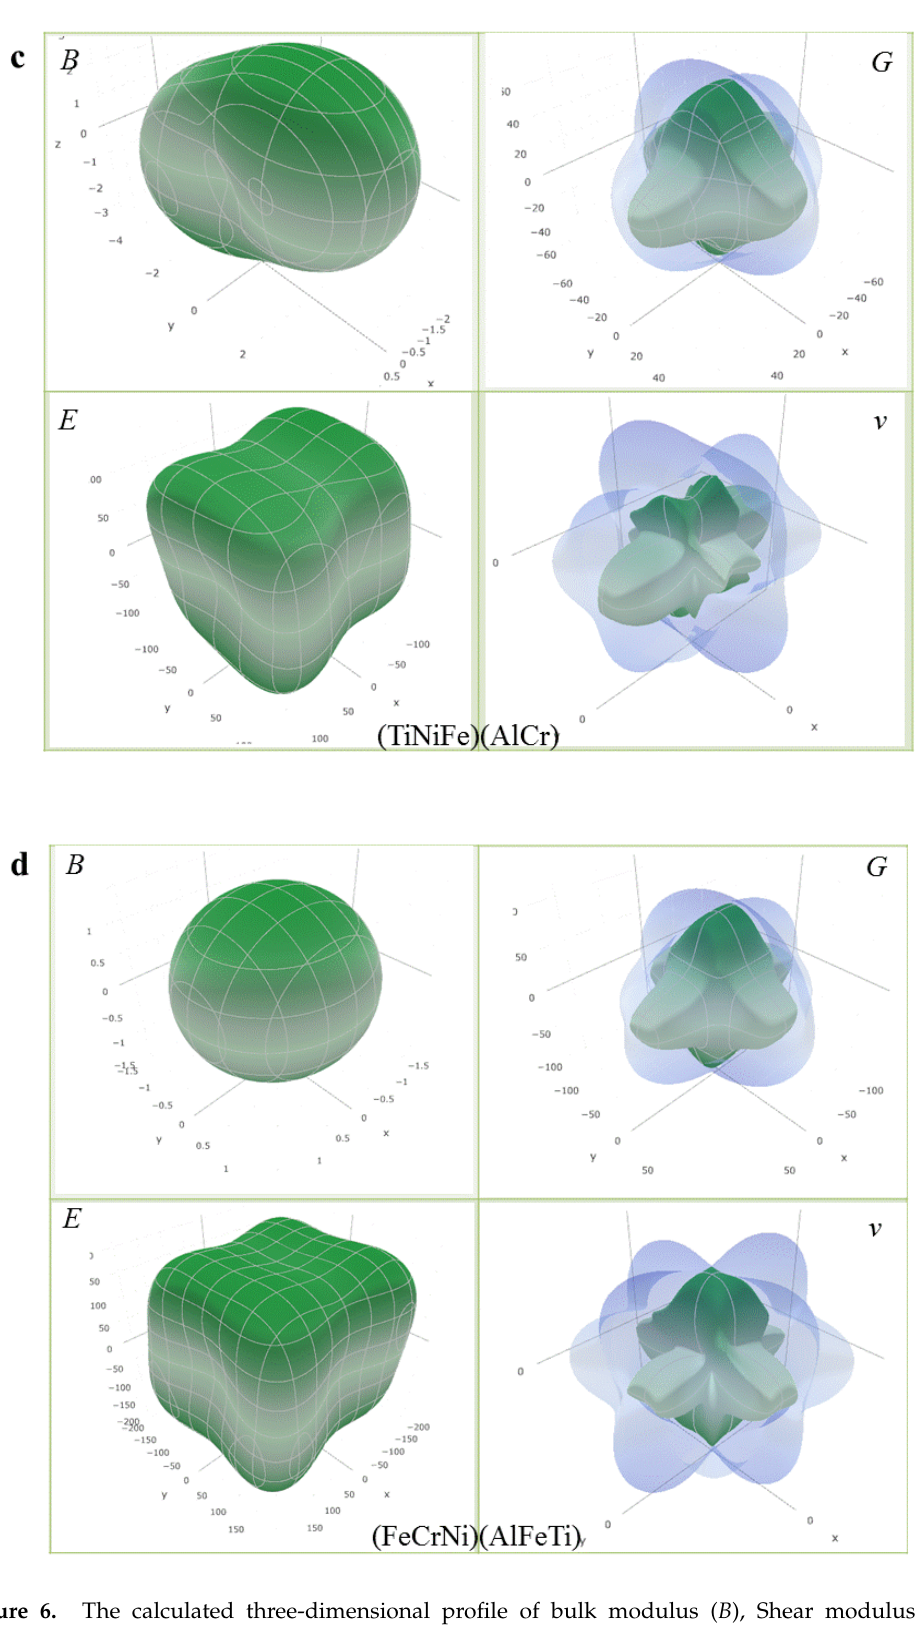
Figure 6. The calculated three-dimensional profile of bulk modulus ( B ), Shear modulus ( G ), elastic modulus ( E ) and poisson’s ratio ( ν ) for single-phase AlCrTiFeNi of di ff erent atom occupancy positions. ( a ) (TiCrNi)(AlFe); ( b ) (TiCrFe)(AlNi); ( c ) (TiCrFe)(AlCr); ( d )